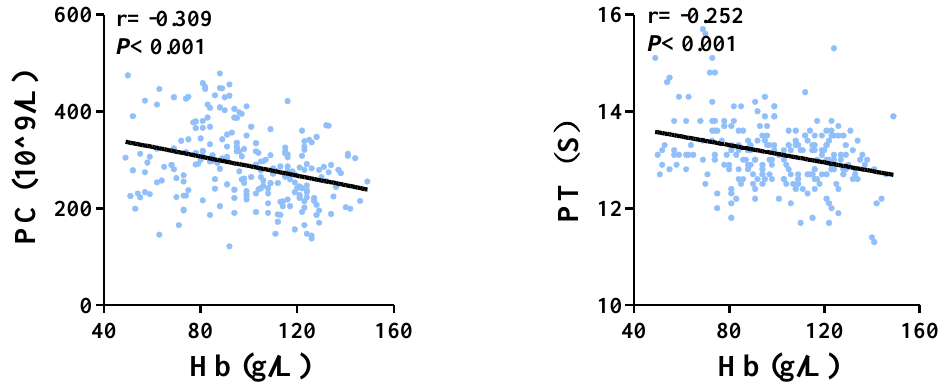
Figure 3. Correlations of PC and PT with hemoglobin PC, platelet count; PT, plasma prothrombin time.